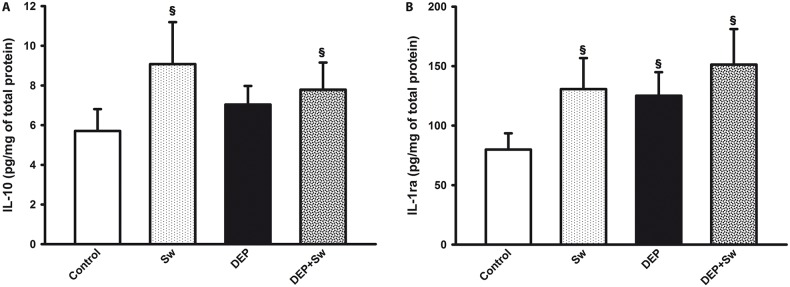
Anti-inflammatory cytokines lung levels.Fig 4 shows the total levels of IL-10 and IL-1ra (Fig 4A and 4B, respectively) from homogenate lung tissue. Values are expressed as mean ± SD. Fig 4A, §p = 0.01, when compared to Control group, and Fig 4B, §p = 0.0002, when compared to Control group also. When compared DEP and DEP+Sw groups, there was no significant statistical difference (p>0.05) in both measurements.